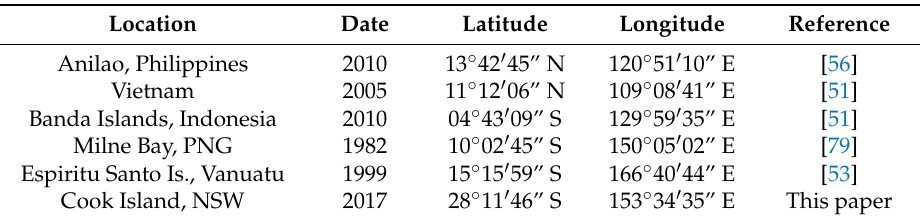
Table 8. Global distribution records of Doriprismatica paladentata.